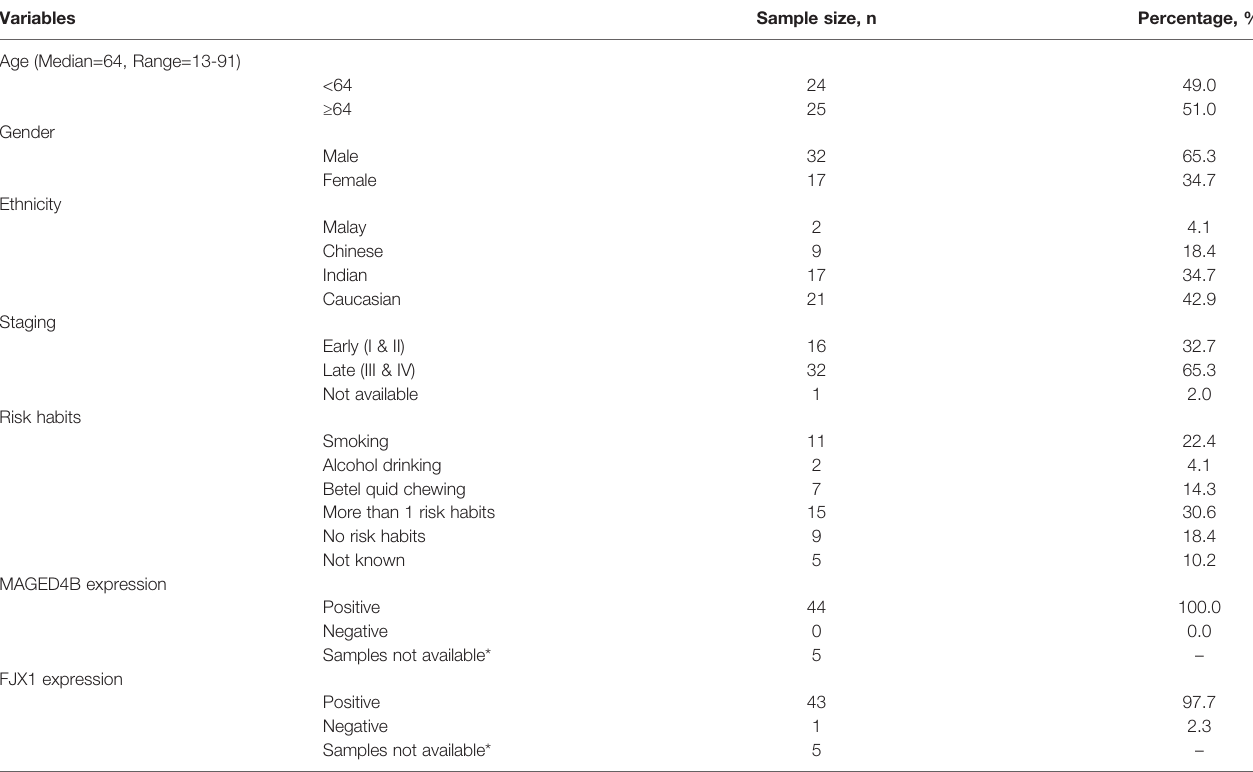
TABLE 1 | The demographic and clinico-pathological information of 49 HNSCC patients included in this study.